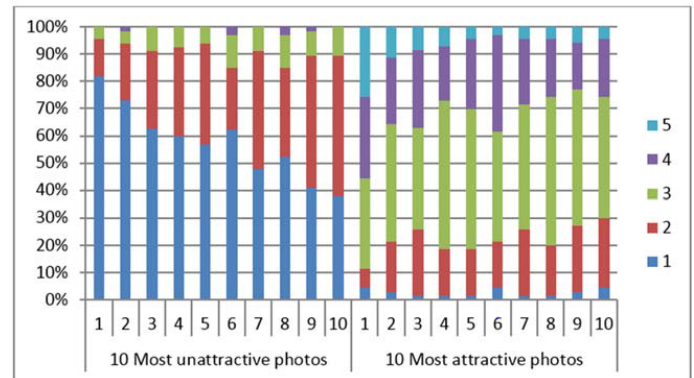
Figure 6. Comparison between accumulated percent of evaluators evaluated the 10 most unattractive and 10 most attractive 3D contour lines at the second time. Evaluators evaluated the 10 most unattractive faces (within 4 scales) more consistency than evaluated the 10 most attractive faces (within 5 scales).